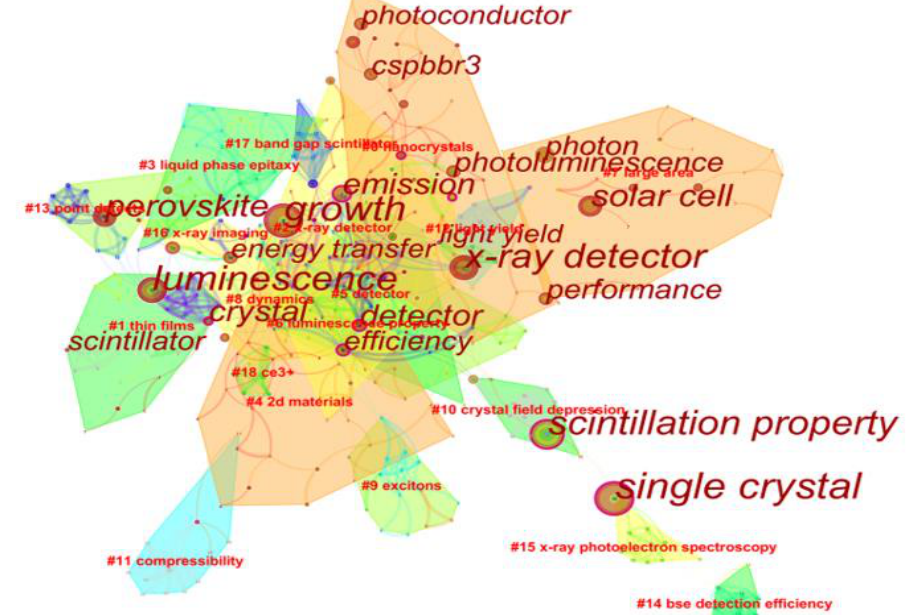
Figure 6. Keyword visualization map after clustering. Table 4. Top 20 keywords according to centrality.